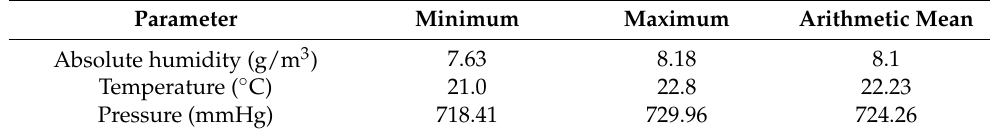
Figure 16. Variation of 50% breakdown voltage with rod (R = 1 mm)–plane electrode system according to different +DC and − DC values: ( a ) +LI; ( b ) − LI. Table 3. Measured ambient conditions for breakdown experiments with (R = 1 mm)–plane elec- trode